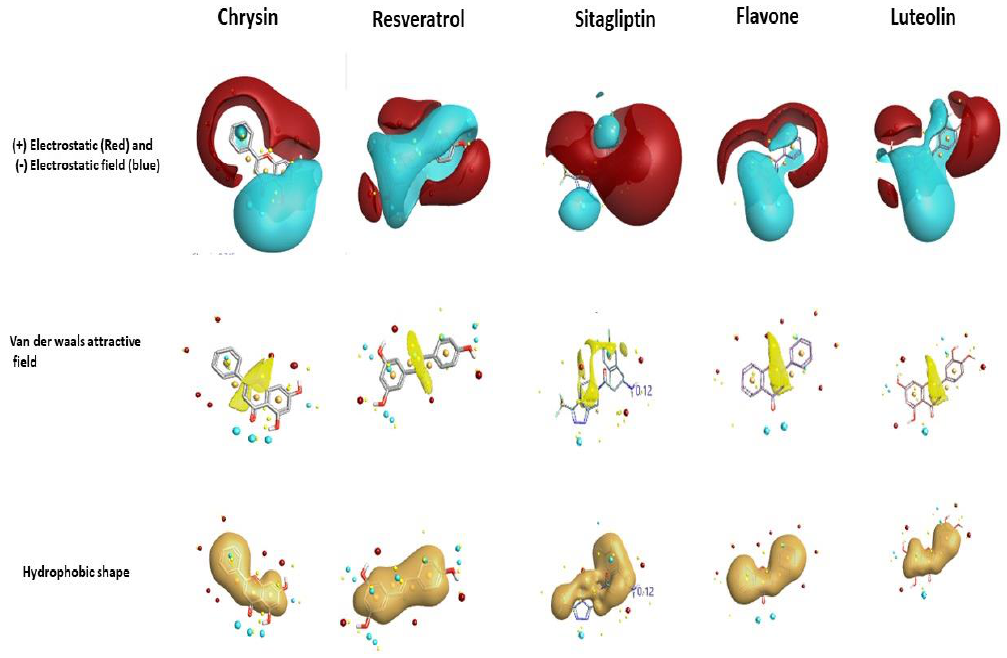
Figure 4. Chrysin bioactive conformation predicted using field template and fields predicted using activity atlas model. Field of chrysin is compared with resveratrol, sitagliptin, flavone, and luteolin.